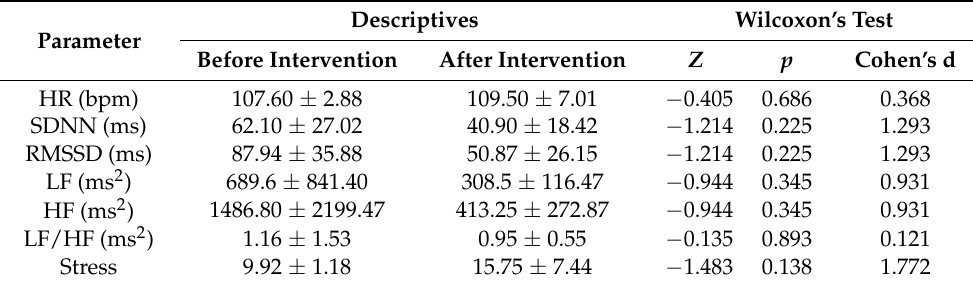
Table 3. Participant 2 statistics and contrast for HRV-related parameters.